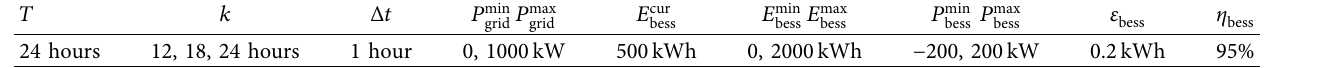
Table 2: Parameter values of the microgrid system in this research.